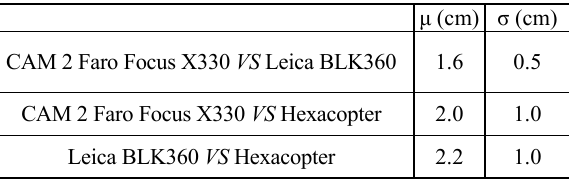
Table 3: Cloud to Cloud absolute distance computation (<5cm) Leica